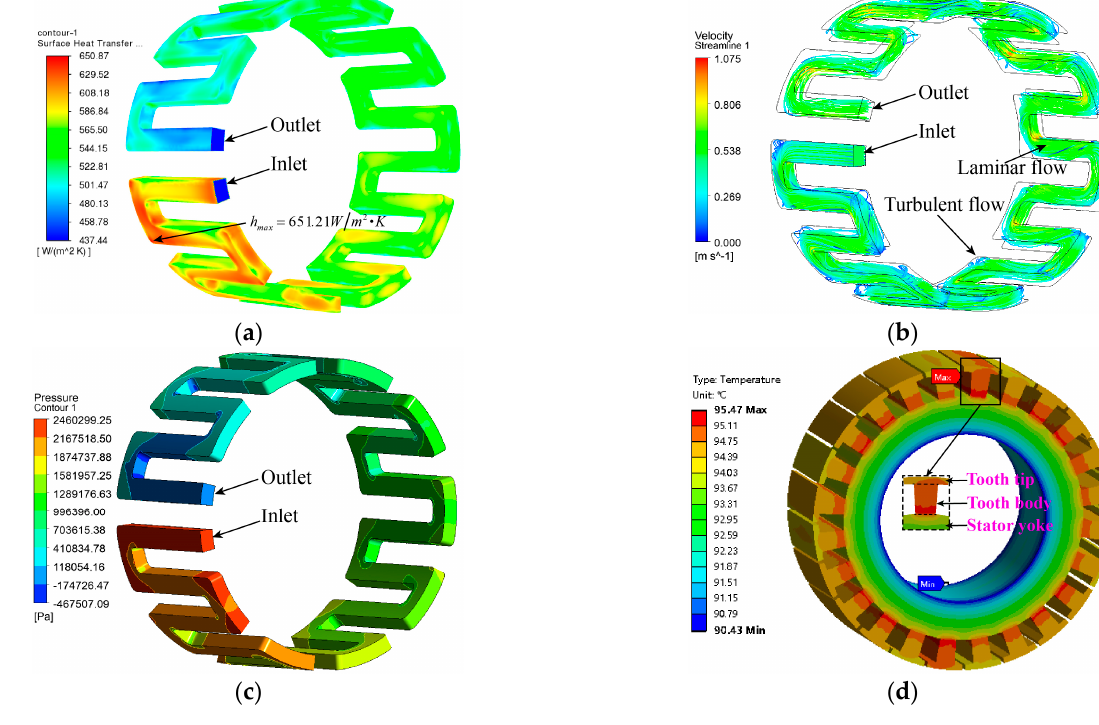
Figure 12. Heat dissipation contour of cooling system: ( a ) CHTC distribution; ( b ) Velocity streamline distribution; ( c ) Pressure distribution; ( d ) Temperature distribution of the stator.